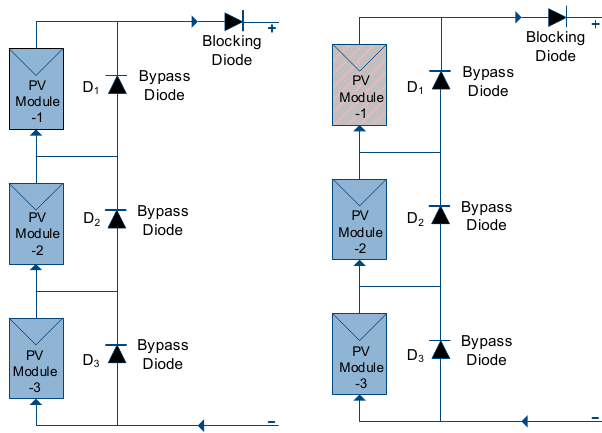
Figure 6. PV array with bypass and blocking diodes under uniform and non-uniform irradiance. Table 1. Review papers published on maximum power point tracking over five years (2015–2020). Maximum Power Point Tracking Review with Non-Uniform Solar Irradiance